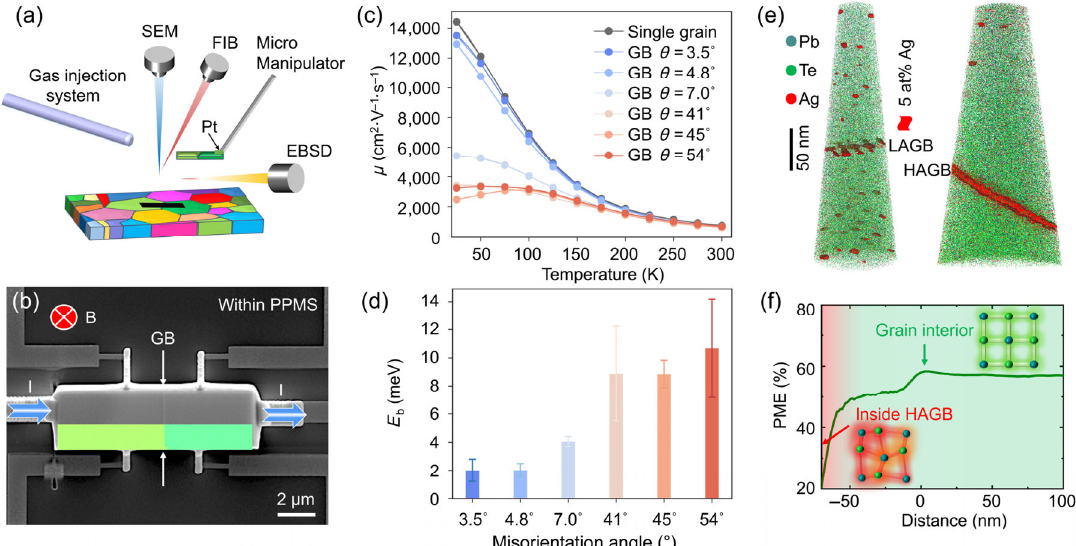
Figure 1 Correlative methods to investigate the microscopic mechanisms of charge carrier scattering at individual grain boundaries. (a) Schematic diagram illustrating the fabrication process of individual GB devices. (b) A hall-bar geometry sample mounted on a micro-scale measurement device with electrodes prepared by electron-beam lithography. (c) Temperature-dependent carrier mobility for samples with individual GBs that differ in misorientation angles. (d) Histogram of the GB potential barrier height showing the increased charge carrier scattering at GBs from LAGBs to HAGBs. The error bars were determined by varying the cut-off data points for linear fitting. (e) Atom probe tomography investigation of two specimens including individual LAGB (left) and HAGB (right). The iso-composition surfaces of 5 at.% Ag depict the Ag-decorated dislocation arrays at a LAGB and the Ag fully covered HAGB. (f) PME profile shows a significant drop of PME inside the HAGB while remaining at a relatively high value in the grain interior. Figures are adapted with permission from Ref. [17], © R. G. Wu, et al.